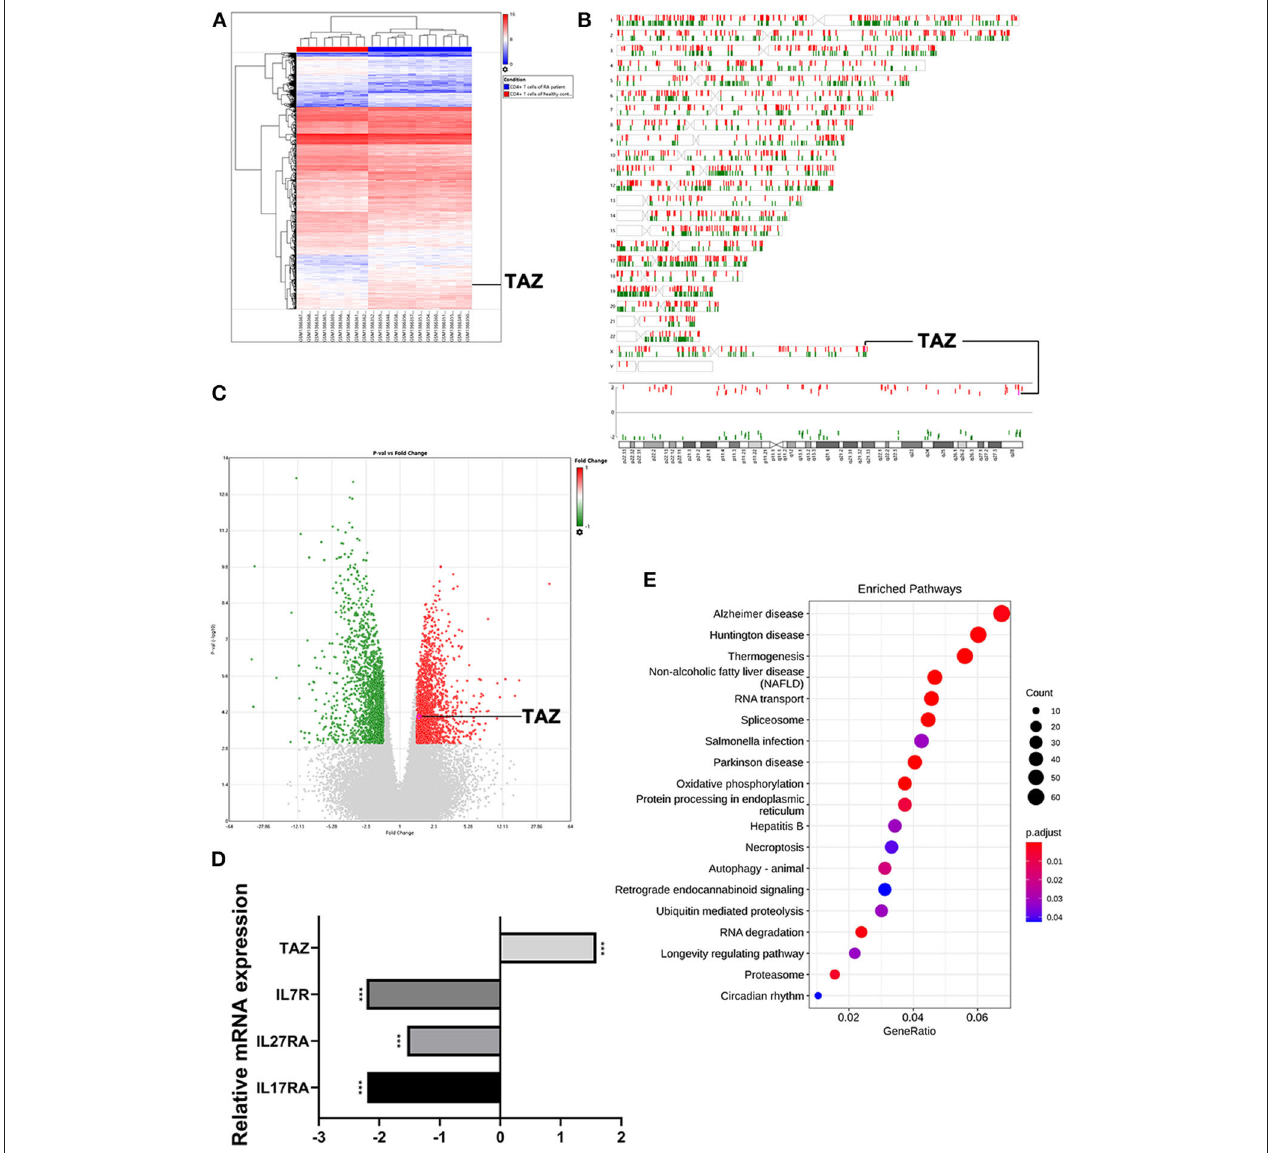
FIGURE 1 | Highly expressed TAZ screened in CD4 + T cells of rheumatoid arthritis patients using microarray raw data analysis. (A) Heatmap of the hierarchical cluster analysis of differentially expressed miRNAs between 13 CD4 + T cells of rheumatoid arthritis patients and 9 CD4 + T cells of healthy individuals using P < 0.001 and |FC| > 1.5 as the cutoff (bright blue, under-expression; white, no change; bright red, over-expression). (B,C) Chromosome summary plot and volcano plot of the microarray data. (D) The expression of TAZ was higher in CD4 + T cells of rheumatoid arthritis patients. (E) Top 20 statistics of KEGG pathway enrichment analysis. *** P <